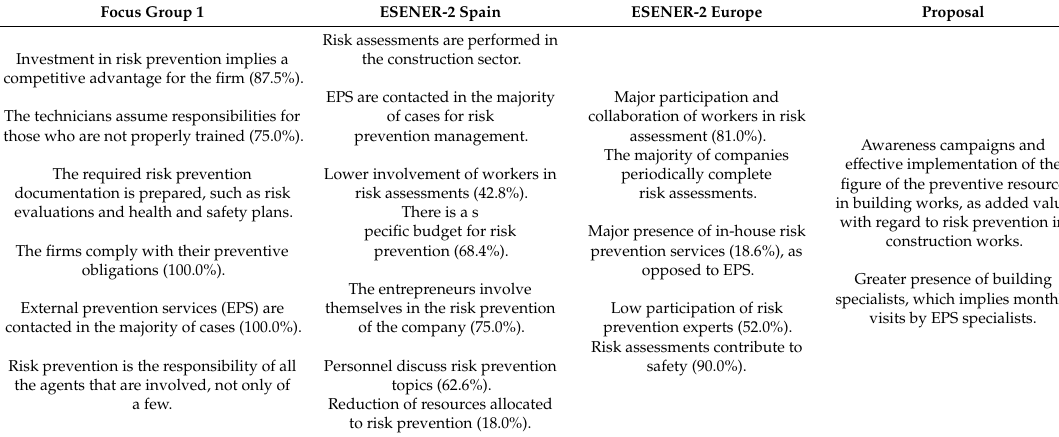
Table 7. Conclusions drawn from focus group 1 and the Second European Survey of Enterprises on New and Emerging Risks (ESENER-2, in both its European and Spanish versions), referring to the fourth indicator (the “risk prevention culture” in the construction sector) used as a guide in the discussion groups. Source: [61,62]. Focus Group 1 ESENER-2 Spain ESENER-2 Europe